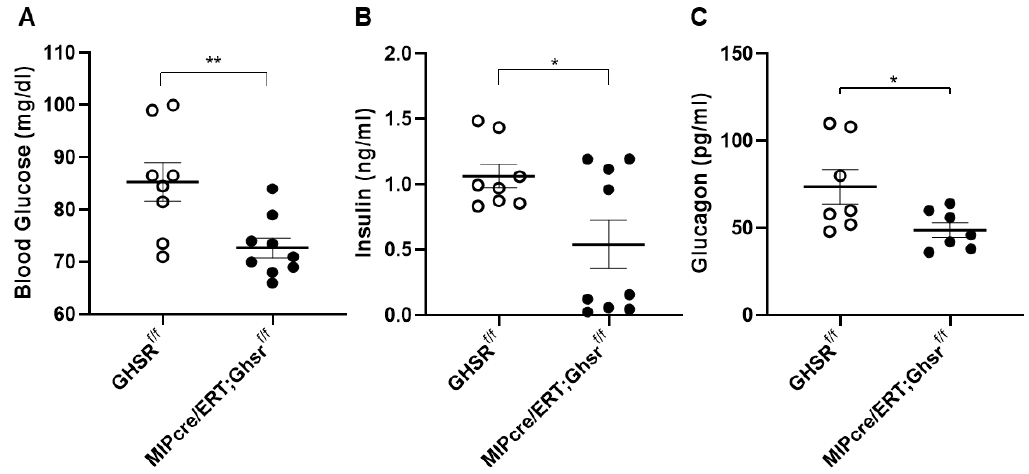
Figure 4. GHS-R ablation in β cells reduced fasting glucose, insulin, glucagon. Four-month-old mice were fasted overnight to measure ( A ) glucose and ( B) insulin. ( C ) Five-month-old mice were fasted overnight, and serum glucagon was measured. n = 8–9. * p < 0.05, ** p < 0.01, Ghsr f/f vs. MIP-CreER;Ghsr f/f .